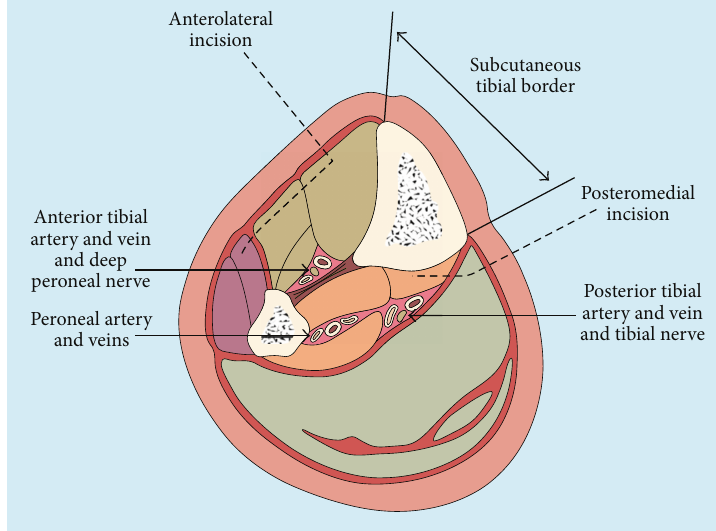
Figure 4: Cross section through leg showing site of fasciotomy incisions to decompress all four compartments [31].